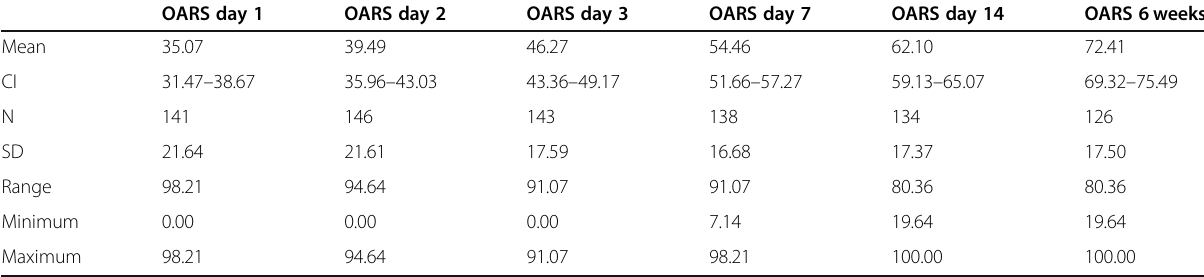
Table 10 Mean overall scores for OARS testing time